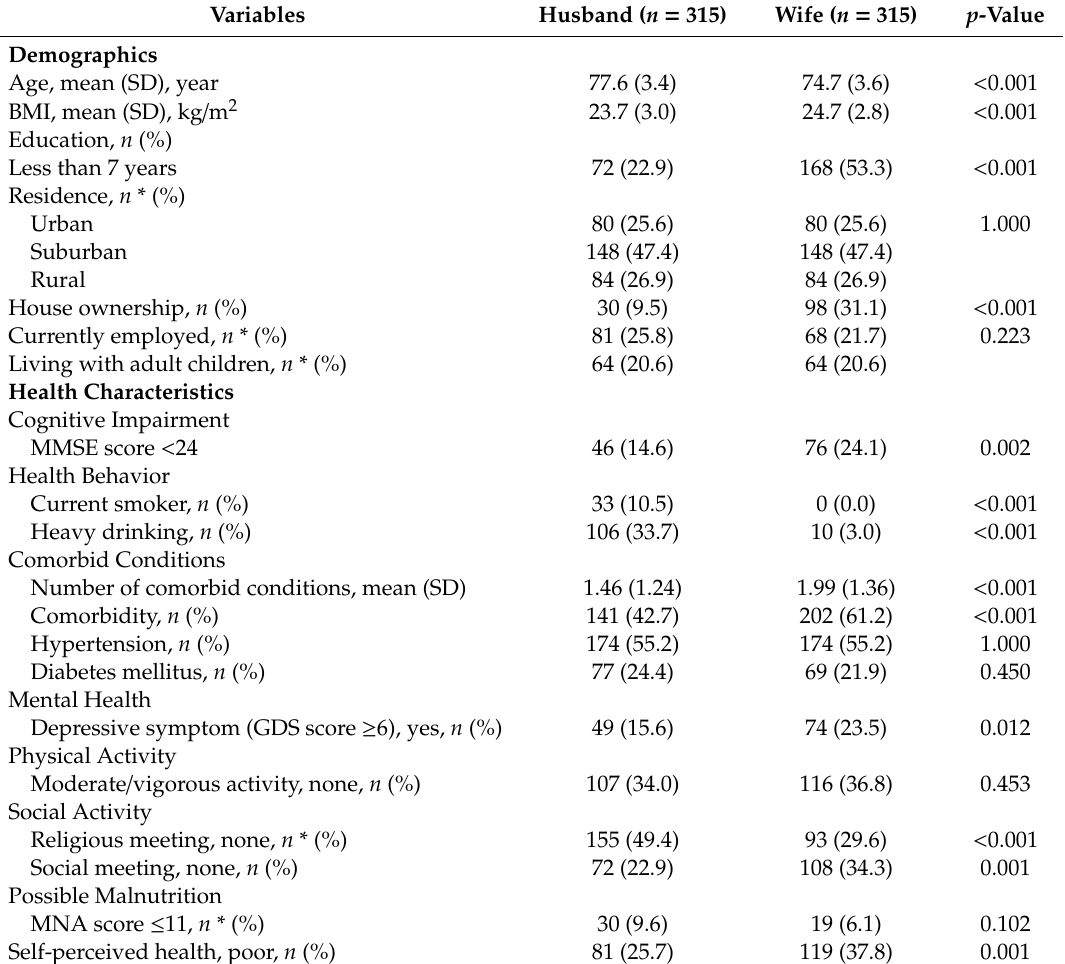
Table 1. Demographic and health characteristics of study participants.